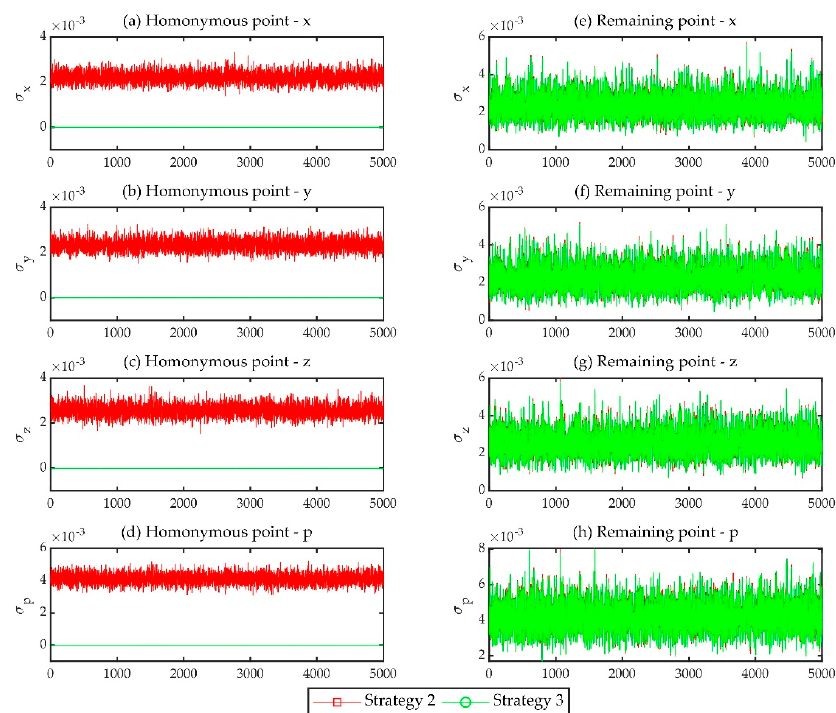
Figure 9. RMSE of points in Case 3 where the horizontal axis indicates the experimental serial number. ( a ) RMSE of homonymous points in x direction; ( b ) RMSE of homonymous points in y direction; ( c ) RMSE of homonymous points in z direction; ( d ) positional RMSE of homonymous points; ( e ) RMSE of checking points in x direction; ( f ) RMSE of checking points in y direction; ( g ) RMSE of checking points in z direction; ( h ) positional RMSE of checking points.